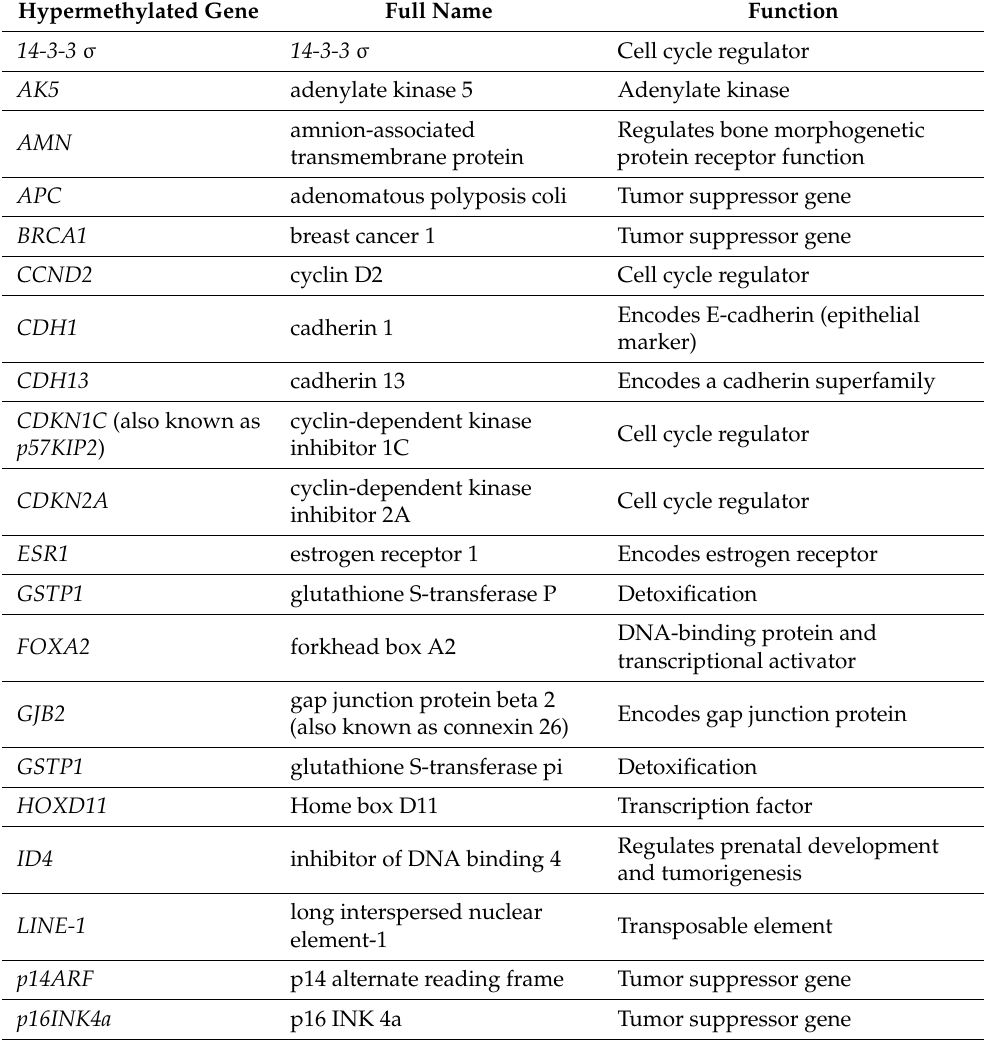
Table 3. Common abnormally methylated genes in HR-positive breast cancer (alphabetical